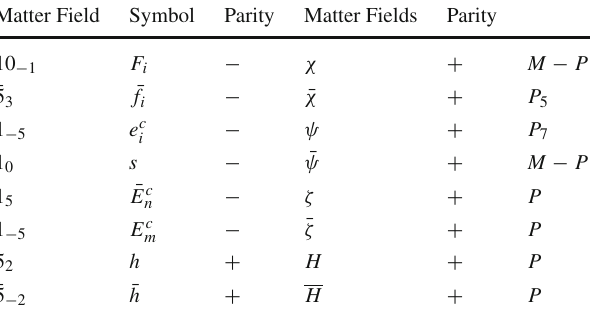
Table3 The SU ( 5 ) × U ( 1 ) χ representationswiththeir R -parityassign- ment. Their multiplicities are counted by the integers M , P , P 5 , 7 in the last column Matter Field Symbol Parity Matter